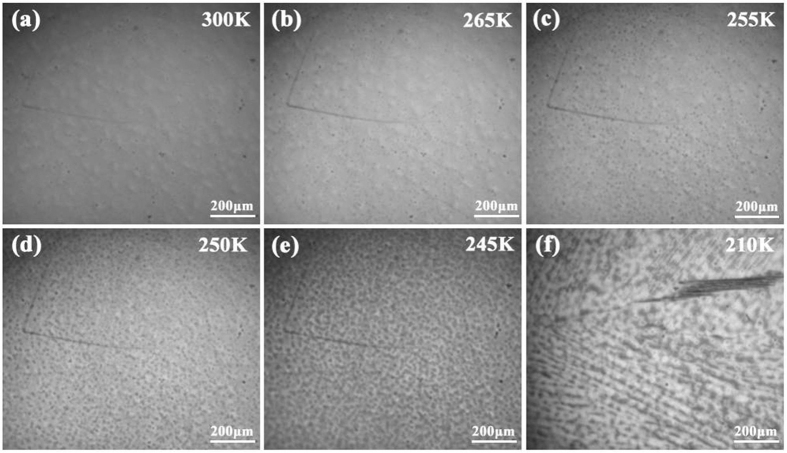
Optical micrographs at different temperatures for Ni50Mn34In15.5Al0.5 alloy upon cooling.